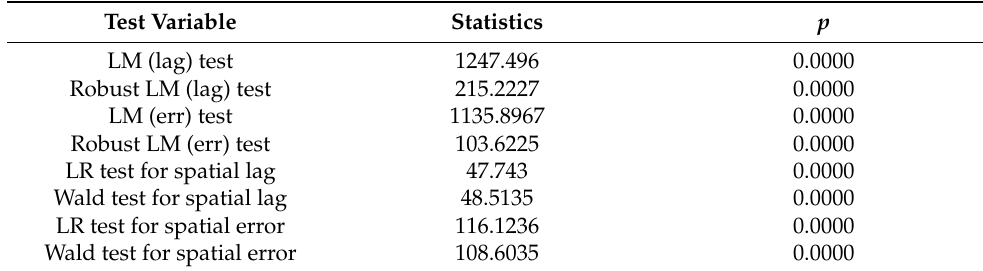
Table 3. L.M. test, L.R. test, and Wald test results of the spatial panel model.